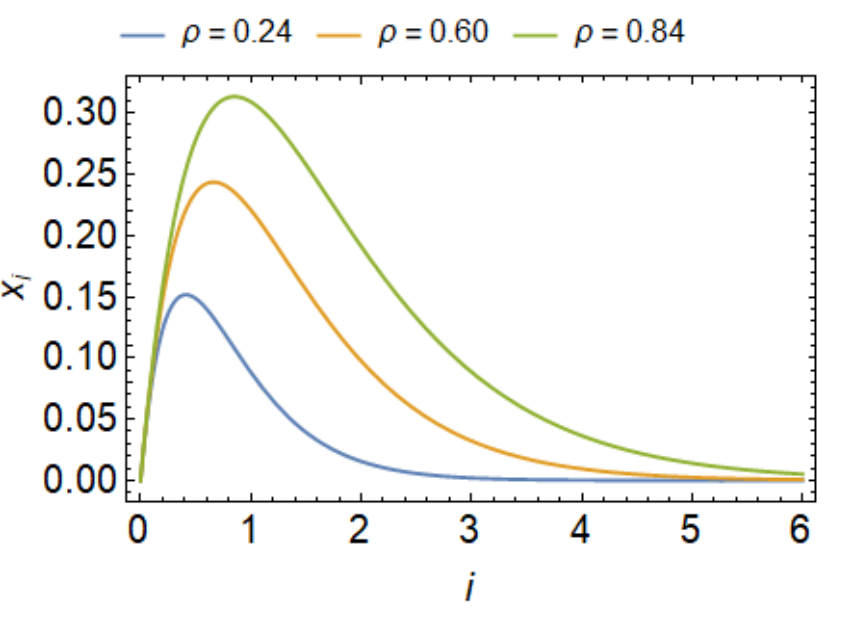
Figure 16. An example of concentrations of aggregates of nanodomains in dependence on number of nanodomains in the aggregate for different number of flexible nanodomains on the